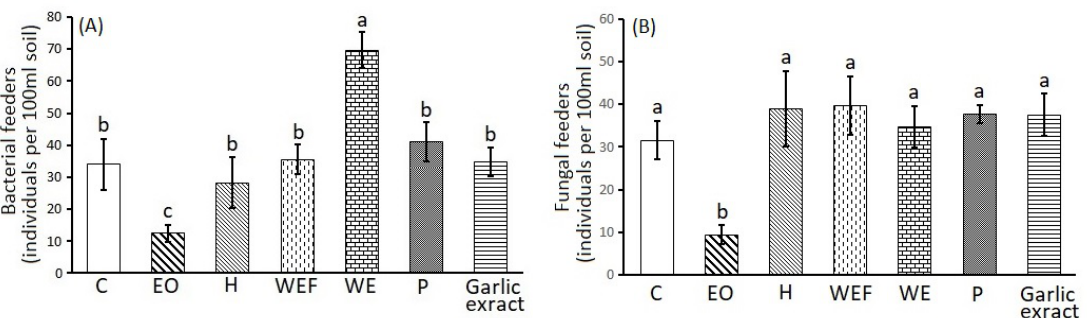
Figure 3. Mean values (± st. error) of soil bacterivorous and fungivorous free-living nematode abundances of the experimental plots (C: water control; EO: essential oil; H: hydrosol; WEF: water extract filtered; WE: water extract; P: powder and garlic extract), 45 days after treatment. Different letters above columns correspond to statistically significant differences between treatments, as revealed by one-way ANOVA (Tukey p < 0.05).